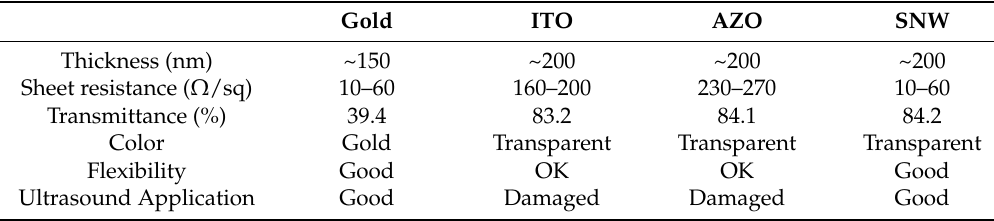
Table 2. Performances of CMUTs with gold, ITO, AZO, and silver nanowire top electrodes.